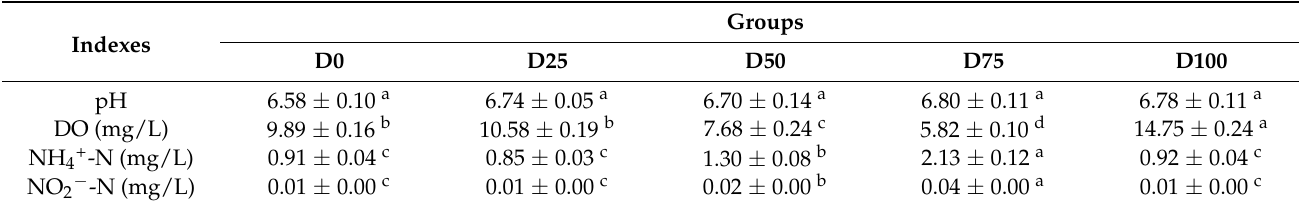
Table 2. Water quality parameters after transportation with different eugenol levels.